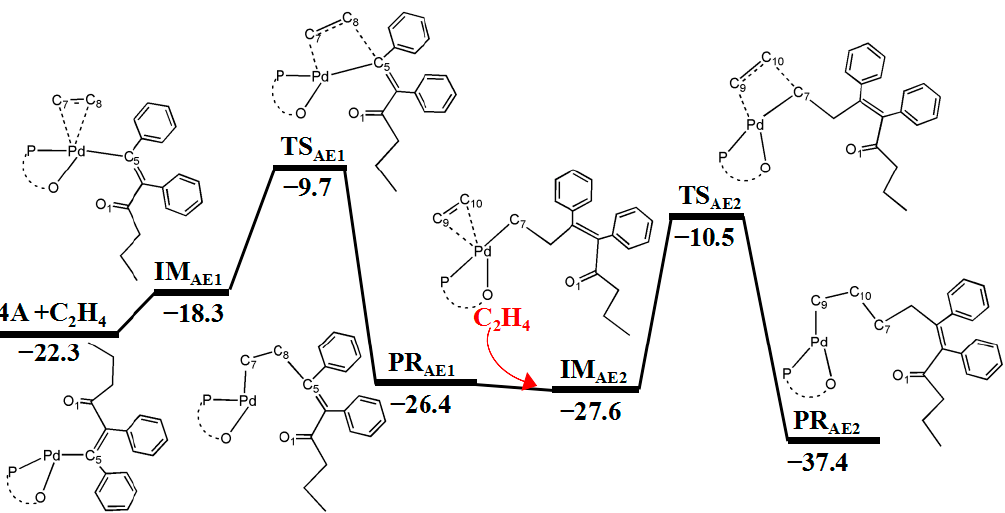
Figure 5. The reaction pathway for continuing ethylene insertion; the relative free energy is given in kcal/mol.